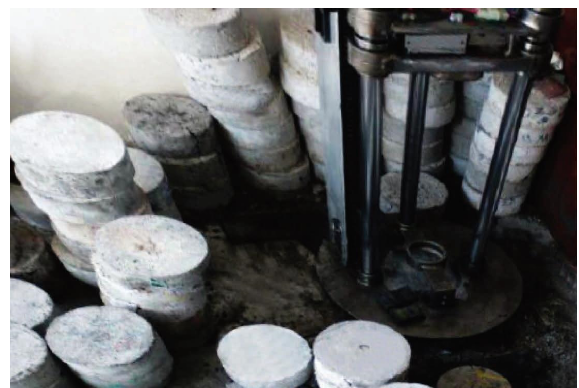
Figure 5: Drop hammer test.